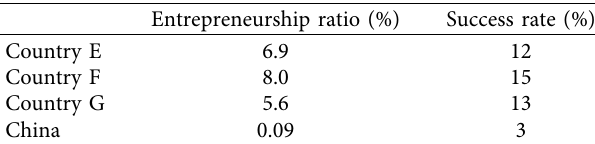
Table 4: Entrepreneurship in E–G countries and